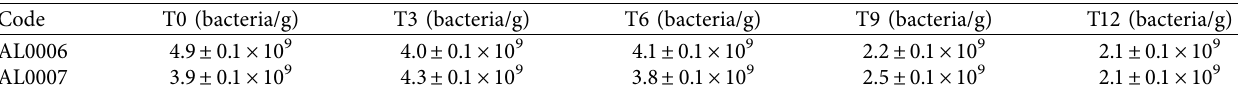
Table 5: Lacto-Counter Assay (LCA) enumeration of bacterial load contained in the two lipogels evaluated at T0 and after 3 (T3), 6 (T6), 9 (T9), and 12 (T12) months on a shelf at room temperature.